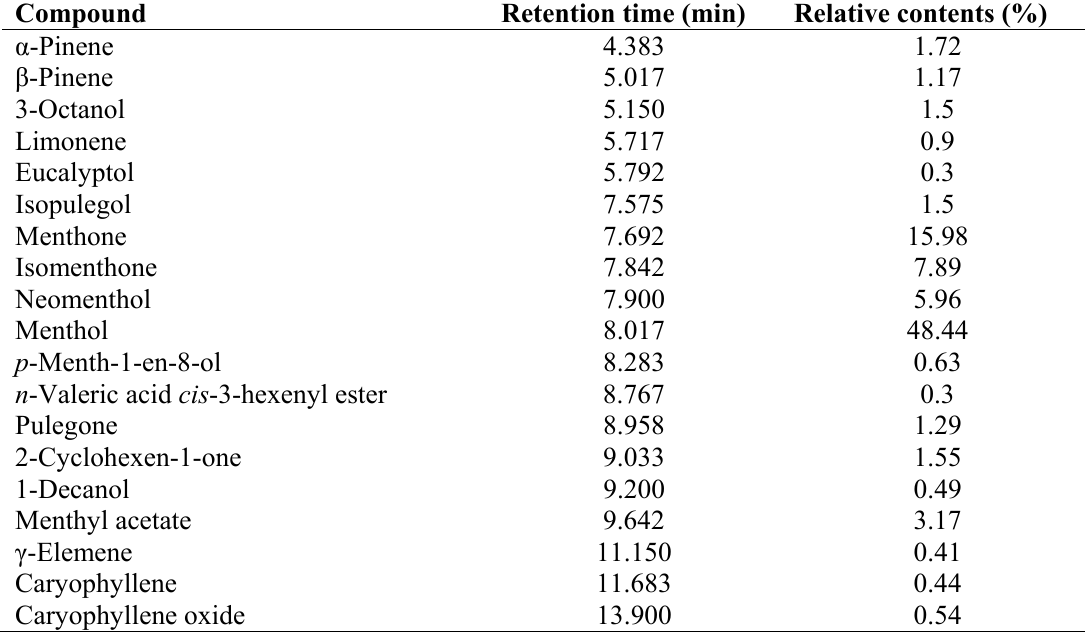
Table 1. The main components of peppermint oil and their relative contents (%). Compound